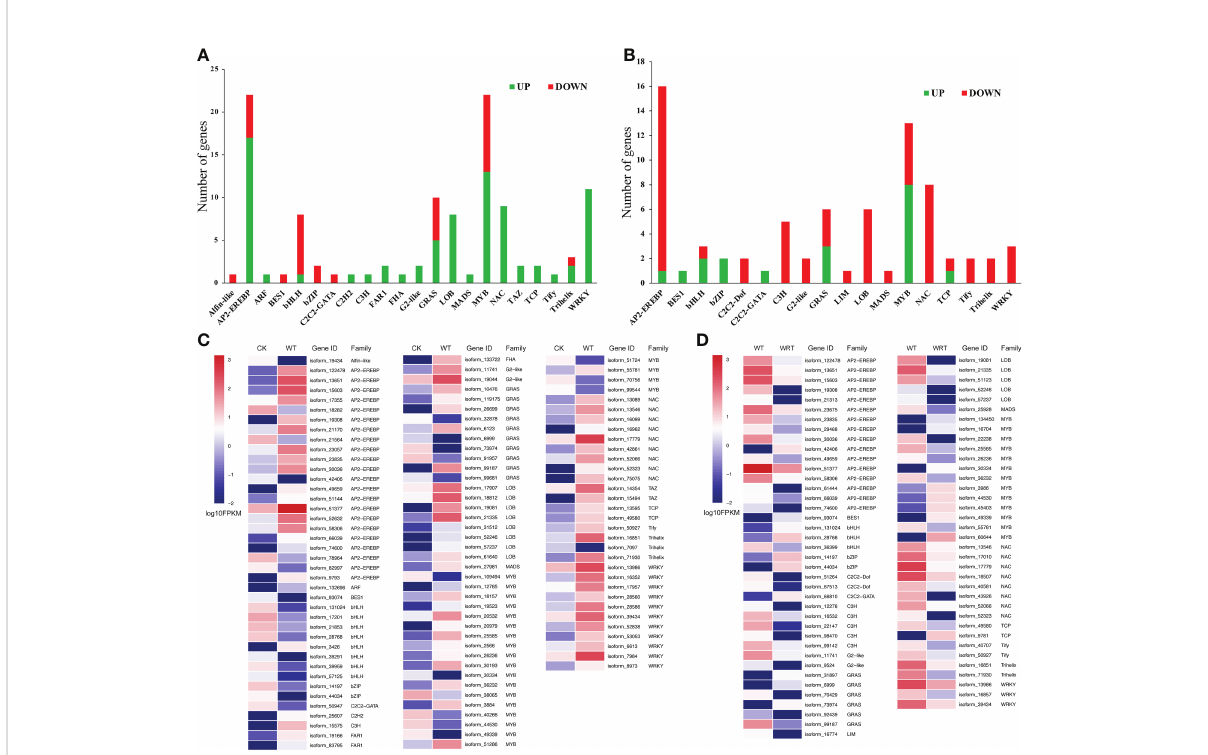
FIGURE 6 DEGs coding transcription factors based on their assigned protein families in P. ostii roots. (A) , Waterlogging treatment (CK VS WT); (B) , Waterlogging recovery treatment (WT VS WRT); (C) , Heatmap of DEGs coding transcription factors under waterlogging treatment; (D) , Heatmap of DEGs coding transcription factors under waterlogging recovery